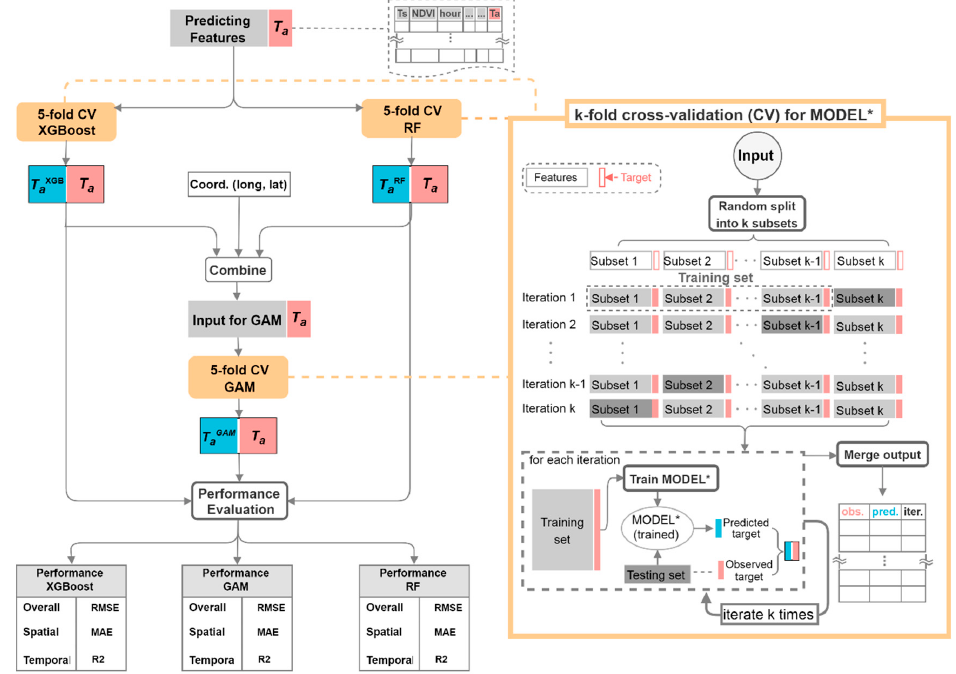
Figure 3. Diagram depicting the 5-fold cross-validation (CV) procedure applied in this study to assess model performance.